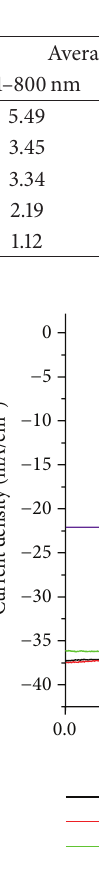
Figure 6: Photoelectric conversion efficiency of the fabricated solar cells subjected to various diffusion temperatures (diffusion time = 60